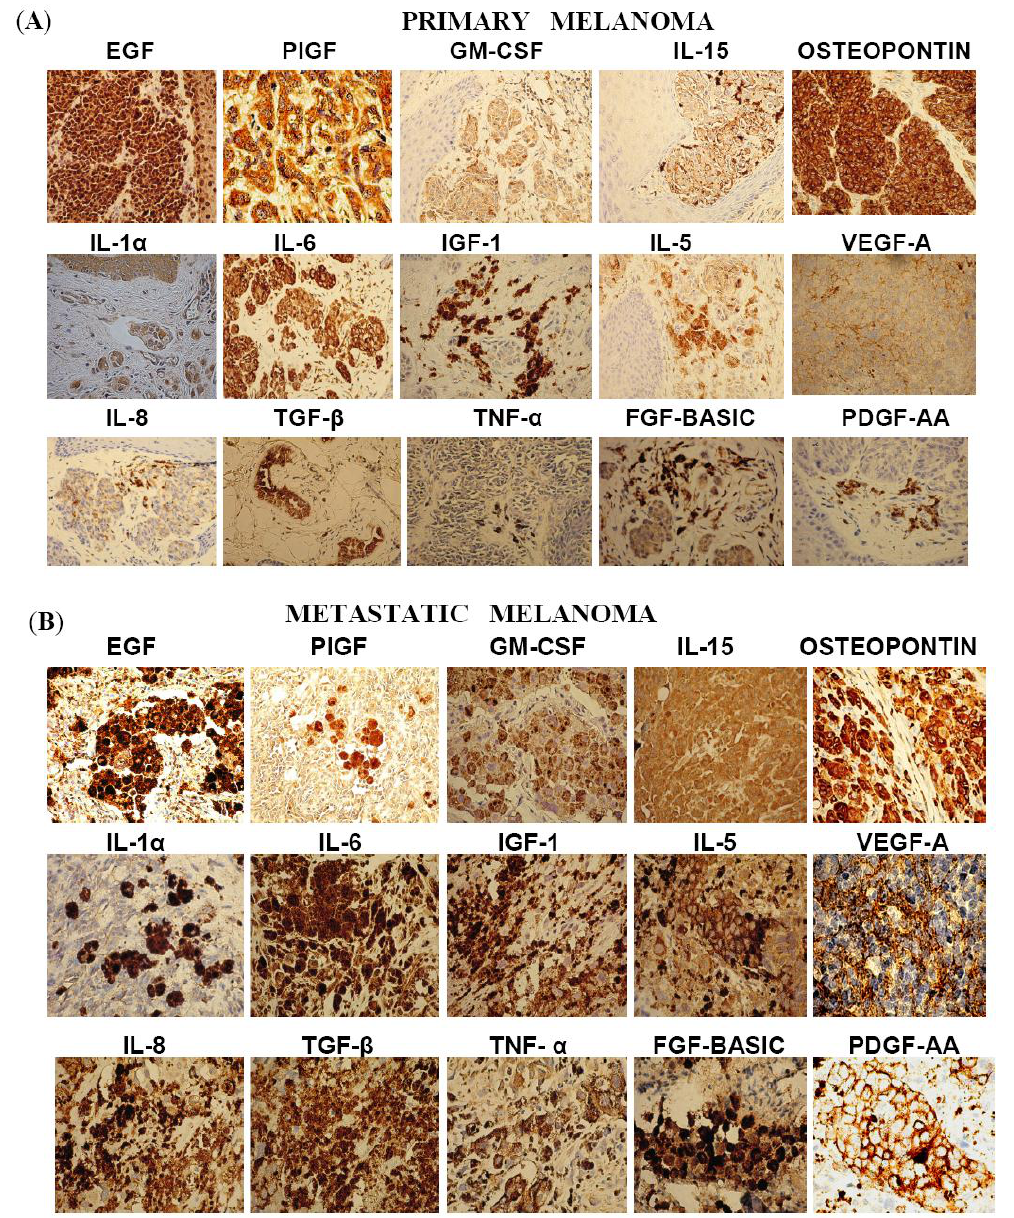
Figure 1. Images of representative IHC staining for factors in primary melanoma (A) and metastatic melanoma